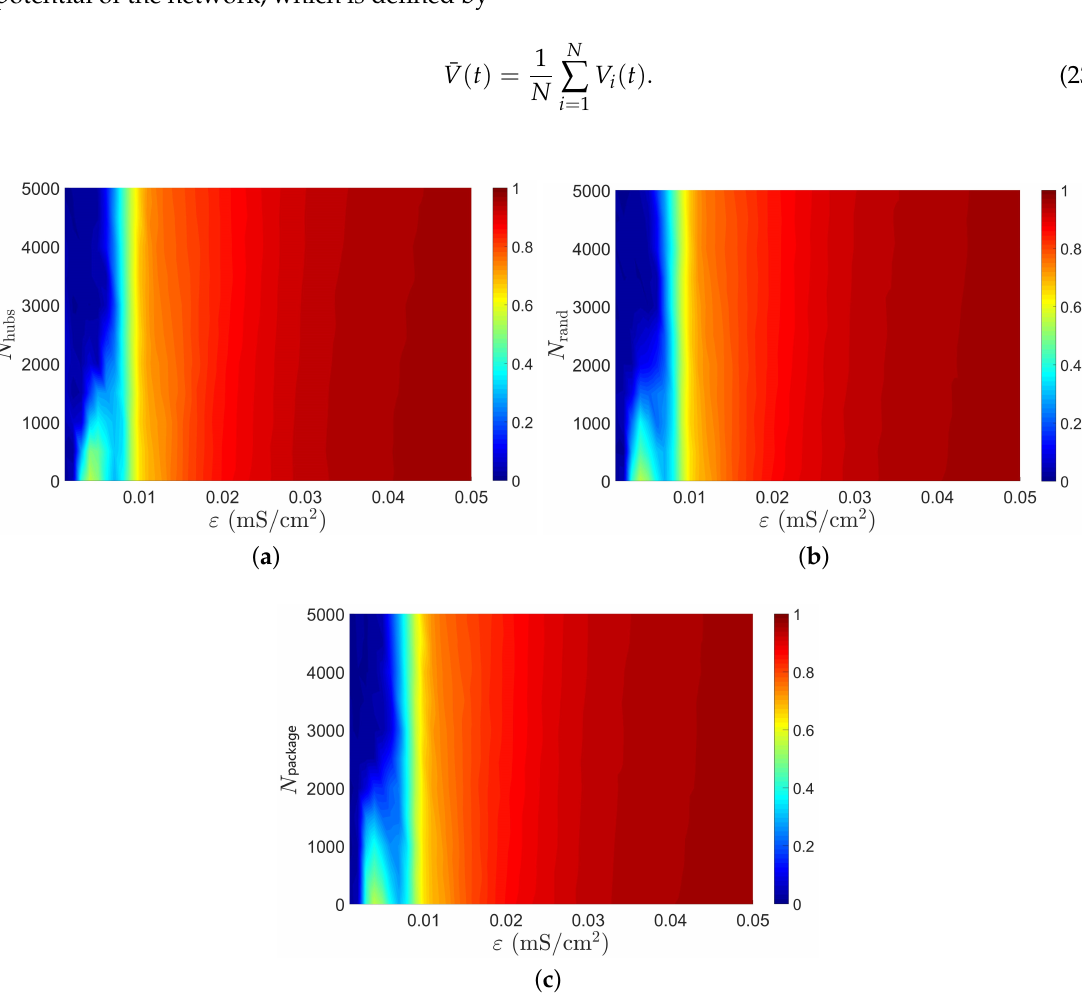
Figure 6. (cid:104) R (cid:105) as functions of ε and the order of the subset |G| which is applied an external pulsed current with λ 0 ( i ⊂ G ) for three different subsets G : ( a ) G consists of the neurons with higher connectivity of the network (hubs); ( b ) G consists of random neurons; and ( c ) G consists of packages of